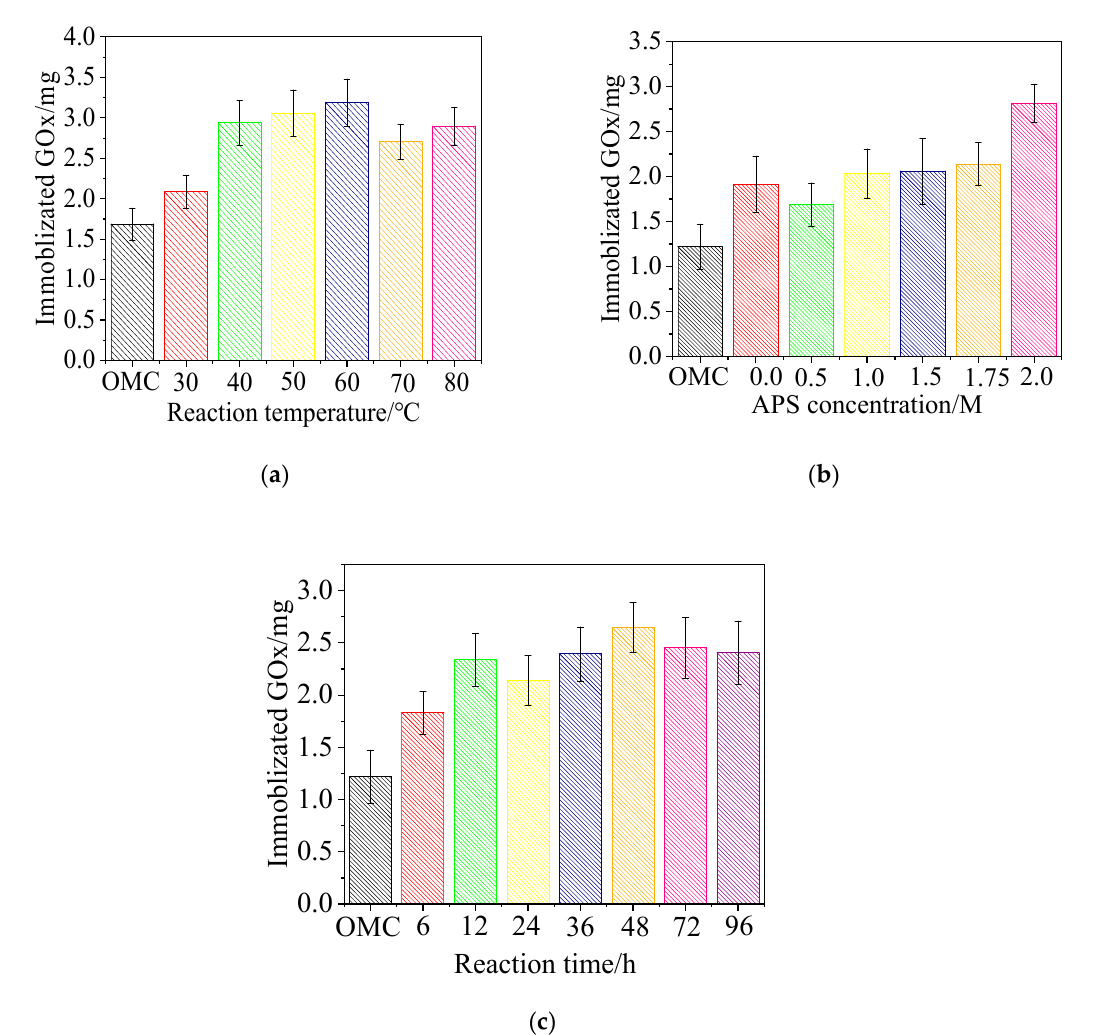
Figure 2. Effects of the carboxylation conditions on the glucose oxidase (GOx) immobilization in carboxylated mesoporous carbon; ( a ) 1.75 M ammonium persulfate (APS), 2 M H 2 SO 4 at different temperature (30, 40, 50, 60, 70, 80 °C) for 24 h; ( b ) 0, 0.5, 1.0, 1.5, 1.75, 2.0 M APS, 2 M H 2 SO 4 at 50 °C for 24 h; ( c ) 1.75 M APS and 2 M H 2 SO 4 at 50 °C for 6, 12, 24, 36, 48, 72, 96 h.